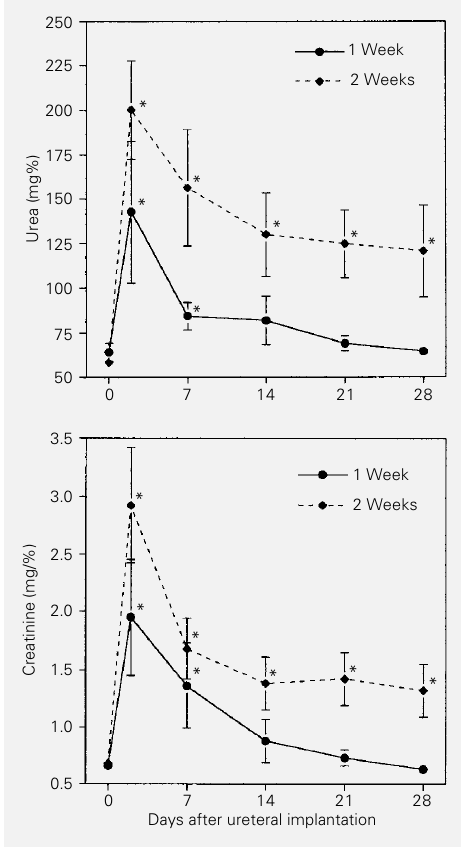
*Figure 2 - - - - - Effect of right uretero- neocystostomy and contralateral nephrectomy following one or two weeks of right ureteral ob- struction on serum urea (top) and creatinine (bottom). Data are reported as means ± SEM, as mg% for 6 rats in each group. *P<0.05 compared to day 0 (Mann-Whitney